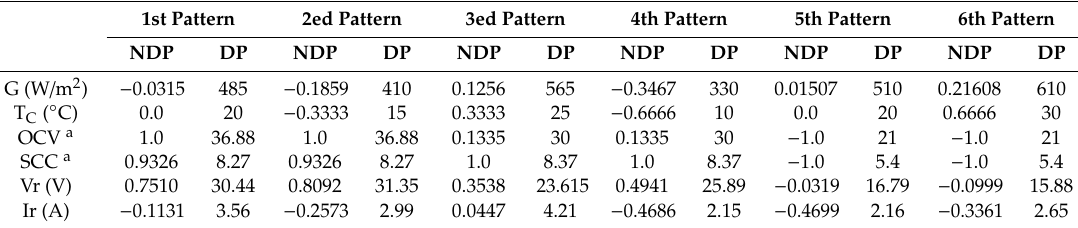
Table 2. Typical random examples of the training sets.